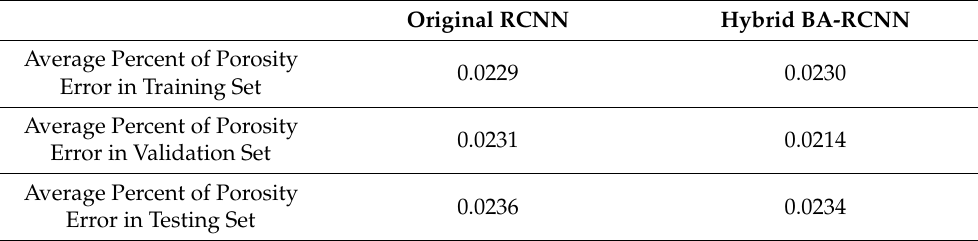
Table 9. Average percent of porosity error (final